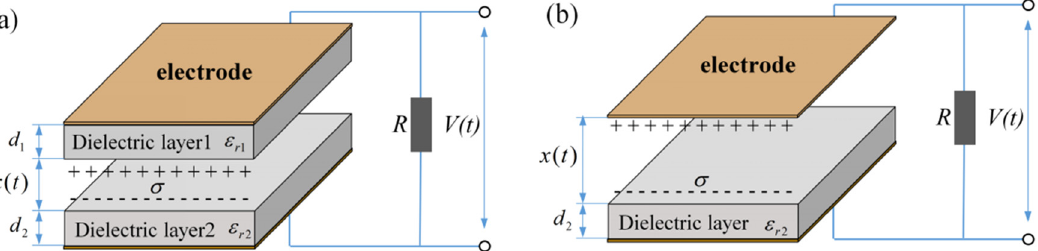
Figure 1: Basic structure and model of a contact - mode TENG: ( a ) dielectric - to - dielectric contact - mode TENG; ( b ) conductor - to - dielectric contact - mode TENG [ 41,54 ]